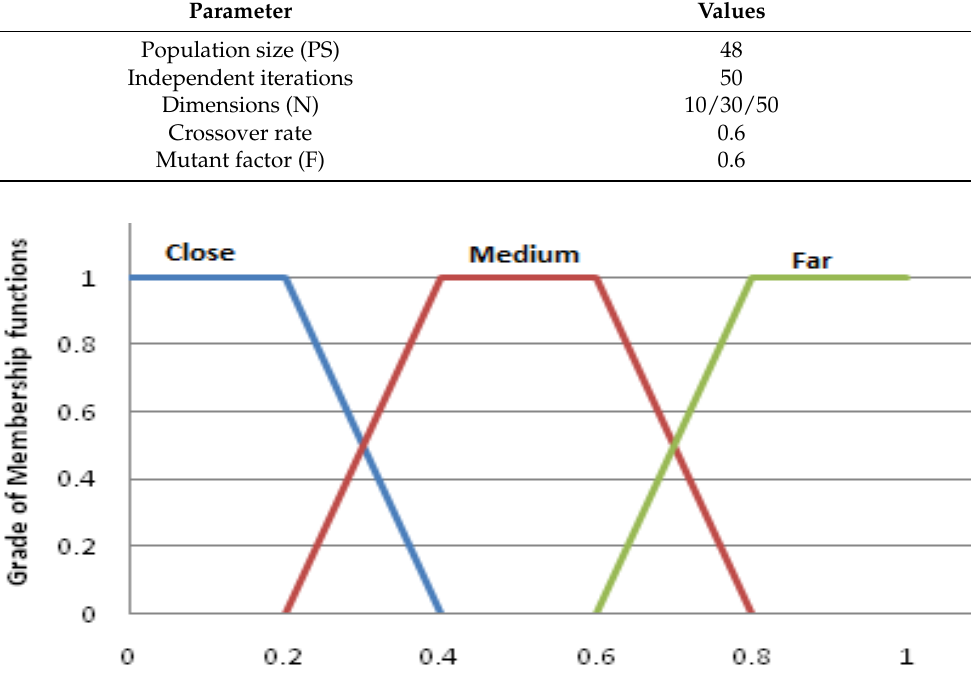
Table 6. Experimental settings of the proposed GA-FIS.